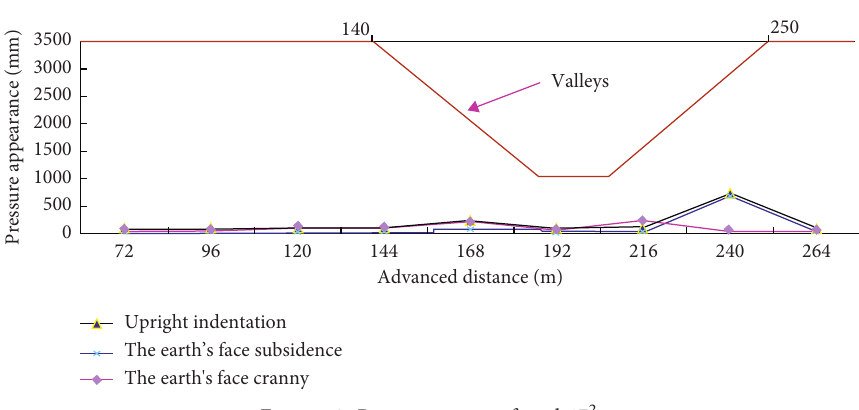
Figure 9: Pressure curve of coal 1 − 2